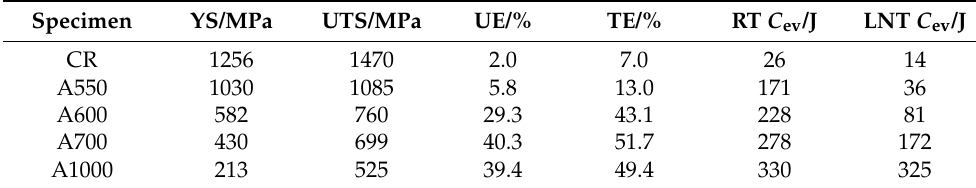
Table 2. Tensile properties and Charpy impact energy of Fe-30Mn-0.05C steel.